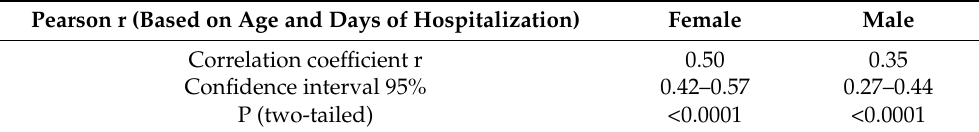
Table 1. Pearson’s r correlation coefficient according to age and hospitalization duration. Pearson r (Based on Age and Days of Hospitalization)